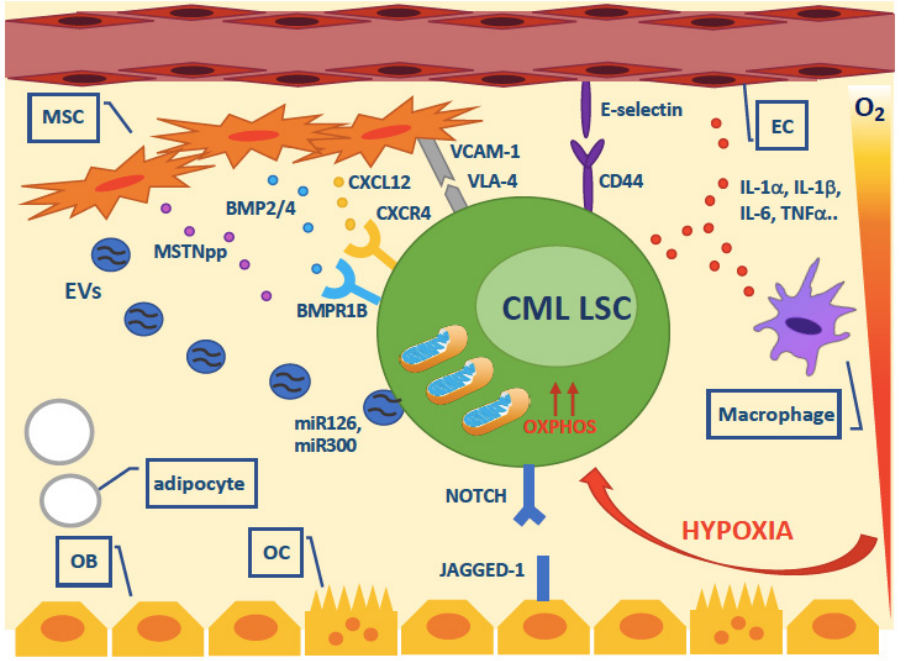
Figure 4. Overview of the cell extrinsic survival factors that have been implicated in CML LSC persistence. Abbreviations: MSC, mesenchymal stromal cell; EC, endothelial cell; OB, osteoblast; OC, osteoclast; EVs, extracellular vesicles.